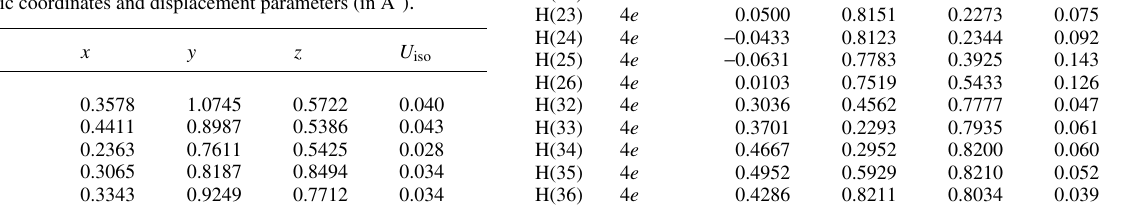
Table 2. Atomic coordinates and displacement parameters (in Å 2 ) .